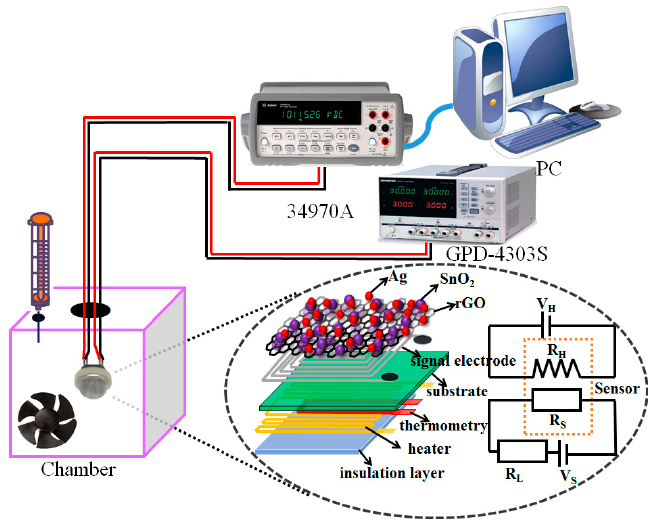
Figure 2. Schematic of the acetylene sensing experimental setup.